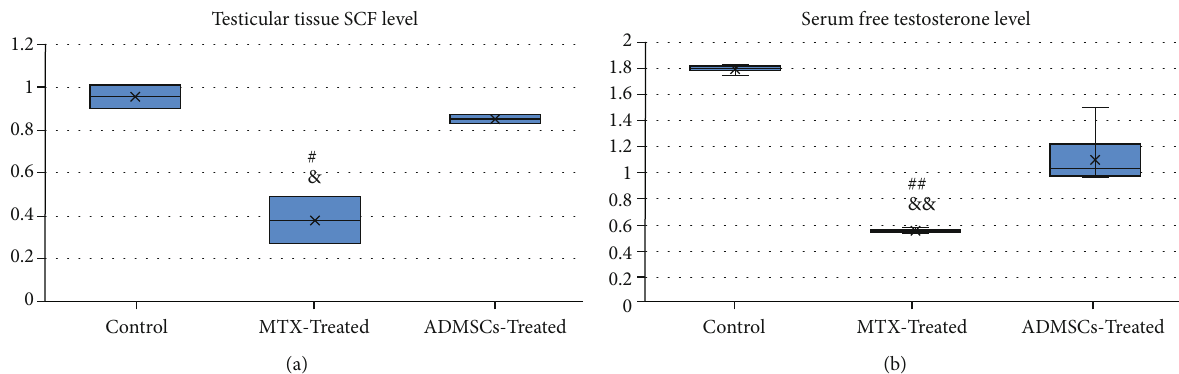
Figure 9: Box blot graph of (a) testicular tissue SCF level (relative expression) and (b) serum testosterone level (ng/ml) among di ff erent study groups. All data were expressed as means ± SD and were analysed using one-way ANOVA and Bonferroni post hoc test. # P < 0 : 05 (signi fi cant), ## P < 0 : 001 (highly signi fi cant) compared to the control group; & P < 0 : 05 (signi fi cant), && P < 0 : 001 (highly signi fi cant) compared to the MSC-treated group.